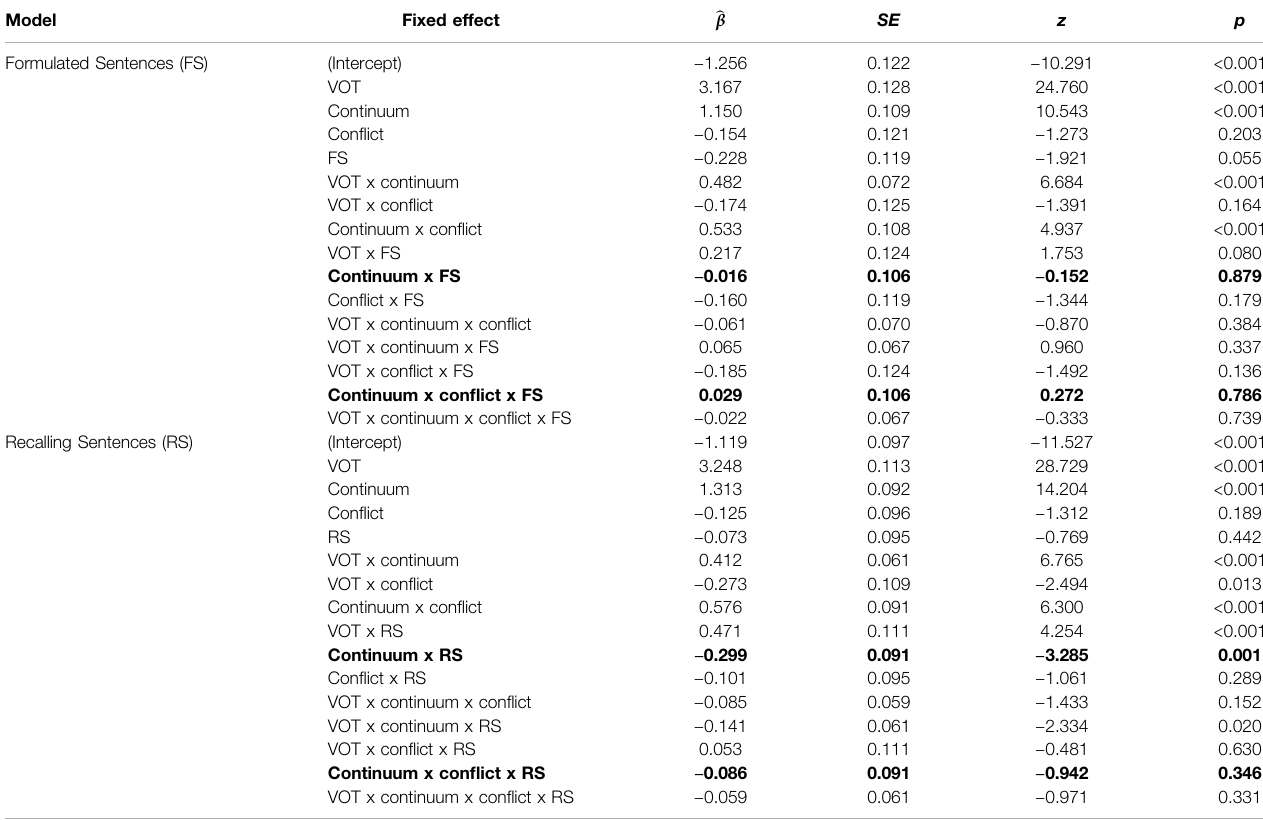
TABLE 2 | Results of the mixed effects models for /k/ responses that included fi xed effects of VOT, continuum, con fl ict, and CELF-5 expressive language subtest (each in a separate model). Bold font is used to mark the key interactions of interest.